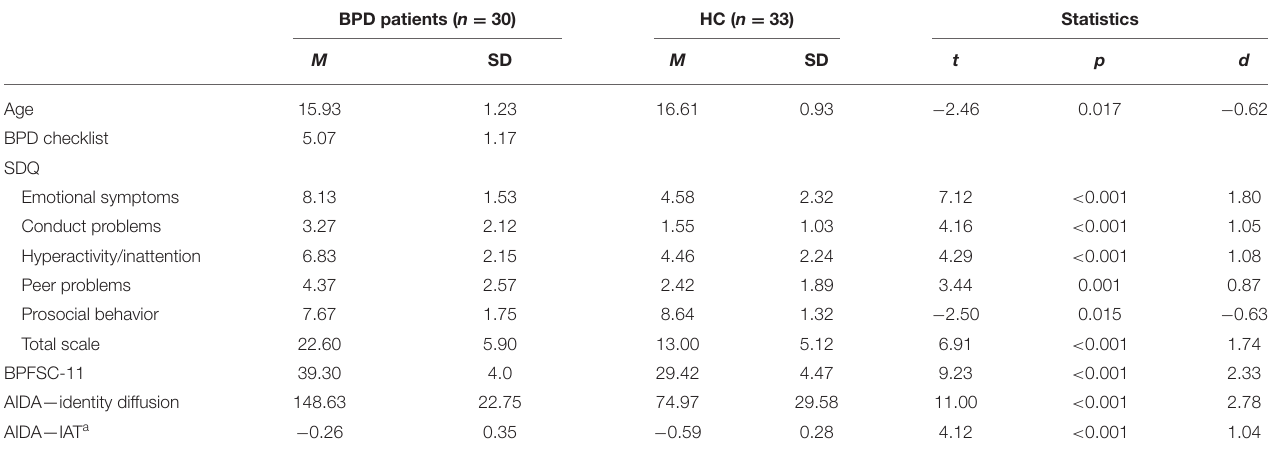
TABLE 1 | Demographic and clinical characteristics of girls with BPD and healthy control participants.